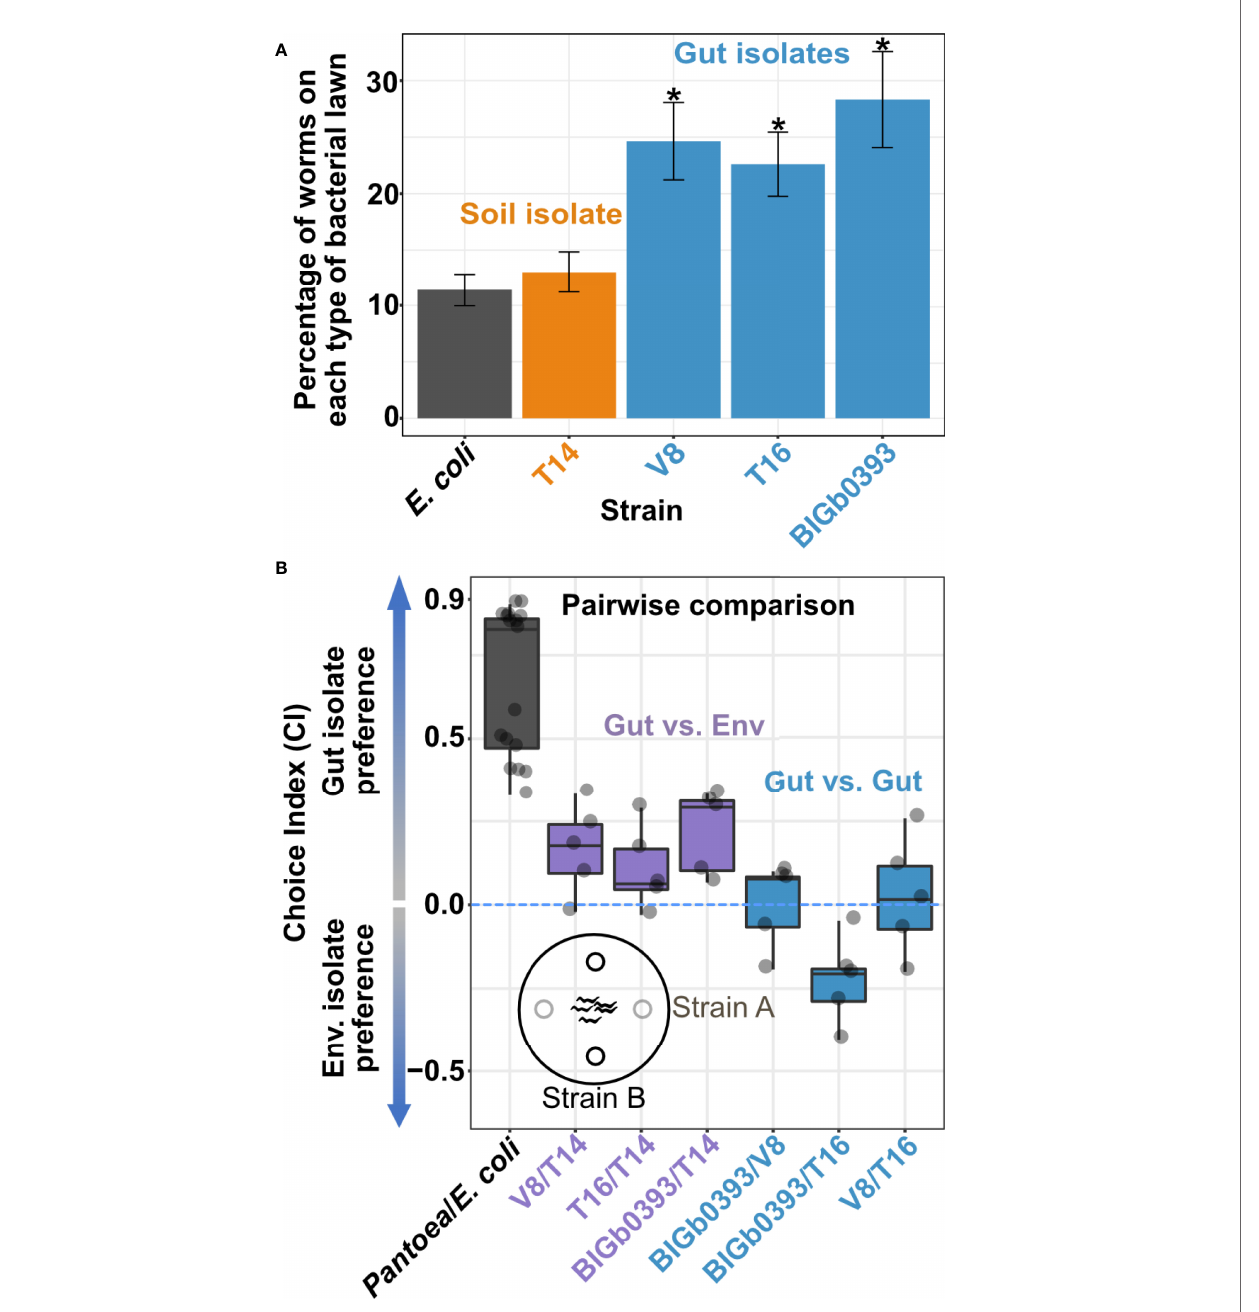
FIGURE 3 | C. elegans shows preference towards bene fi cial Pantoea. (A) Multi-strain plates. Shown are percentages of young adult worms localized to spots of the designated strains after a three-hour incubation at 25°C. Shown are averages ± SEM for 10 plates (N=36-164 worms each). * p <0.01 (Student ’ s t-test). (B) Pairwise preference comparisons. Shown are choice index values of young adult worms exposed to designated strains for 3 hours. Each dot represents an independent pairwise comparison between the designated Pantoea strains (N=21-123 worms per comparison), with boxes de fi ning the 25 to 75 percentile values and lines representing the median